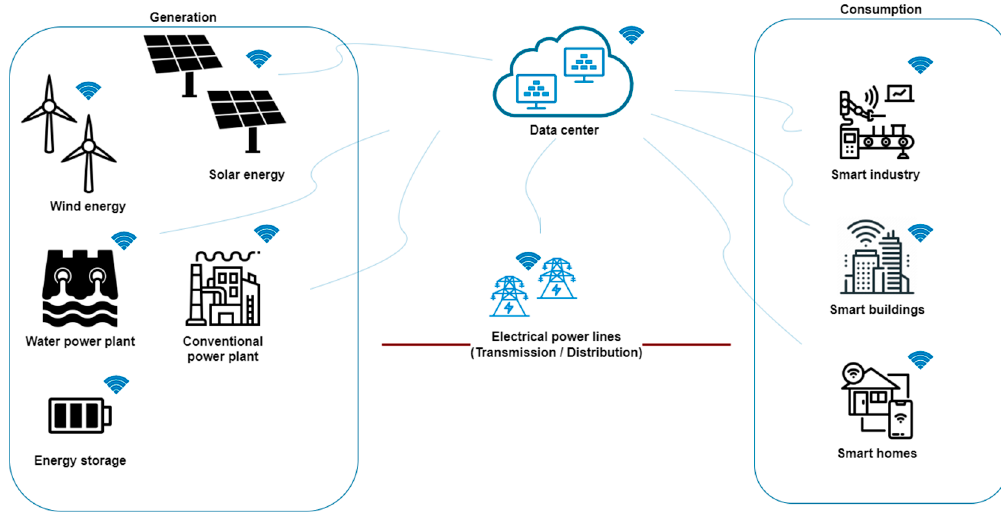
Figure 5. Energy trading architecture in the smart